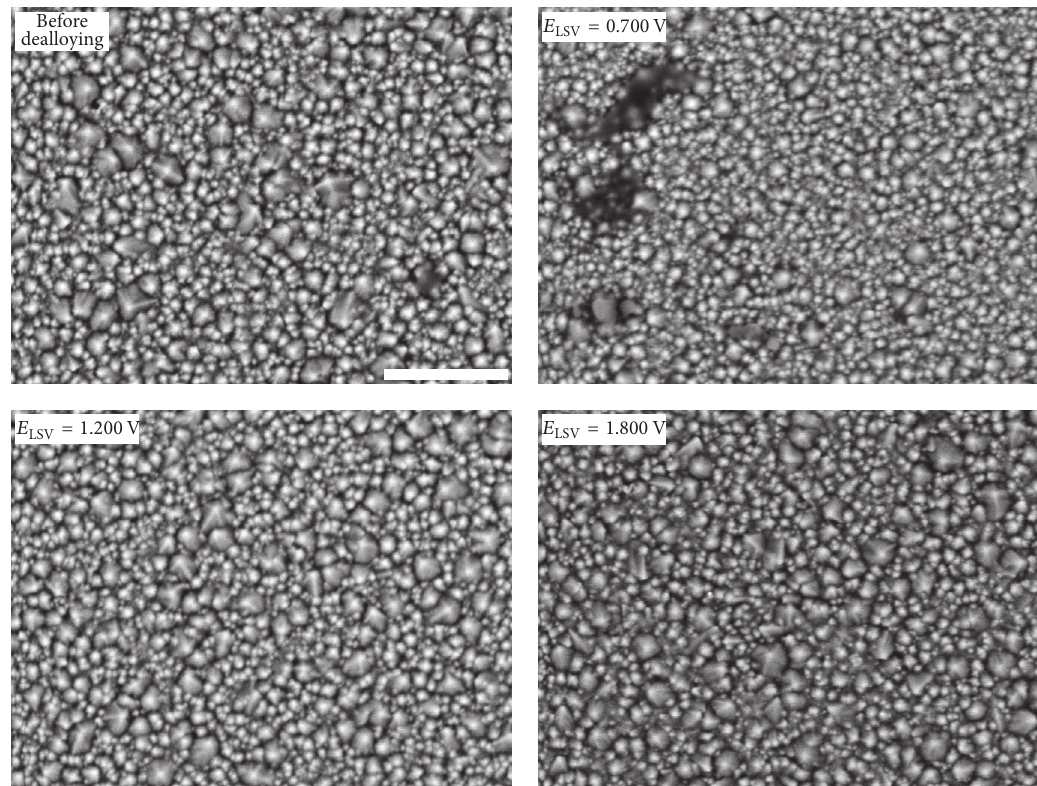
Figure 8: SEM images of samples from the low Ni percentage NiCo samples (Set B) before dealloying and after different dealloying steps. The scale bar is 5 𝜇 m for all the images.